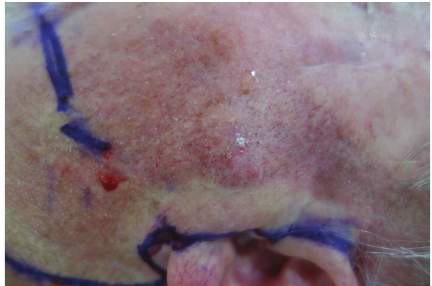
Figure 1: Pre-op photo showing left parotid lesion.